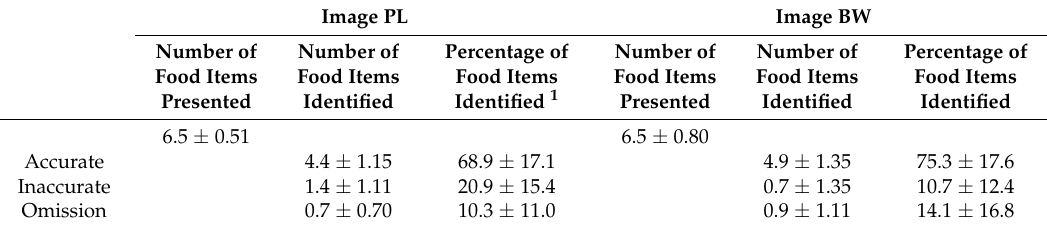
Table 2. Participants’ accuracy of food item identification for Image PL and Image BW (mean ±